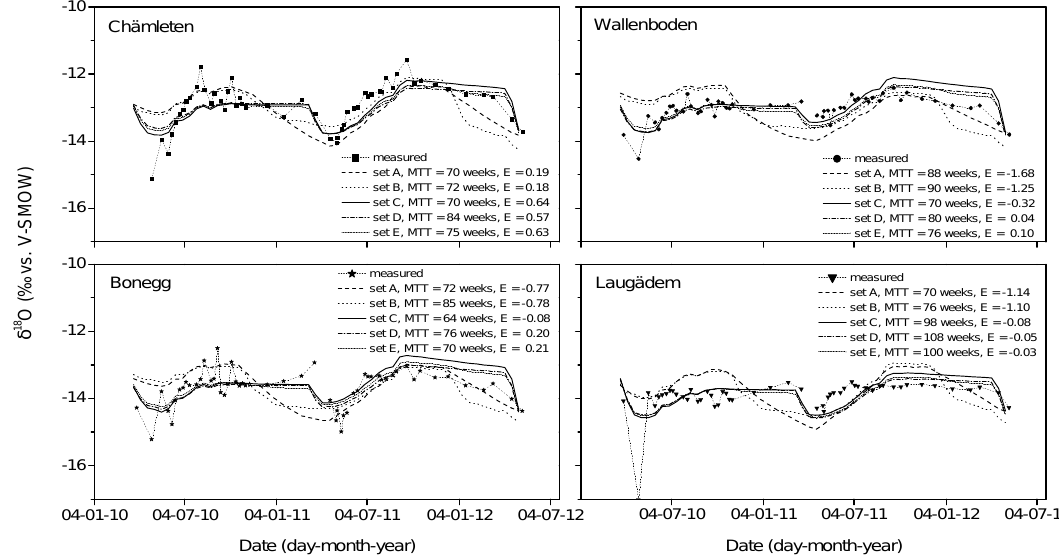
Fig. 7. Measured and modeled stable isotopes ( δ 18 O of H 2 O) in stream water base flow in the four micro catchments. The best fit according to Fig. 6 for each input parameter set and the model efficiency ( E ) according to Nash and Sutcliffe (1970) are shown.